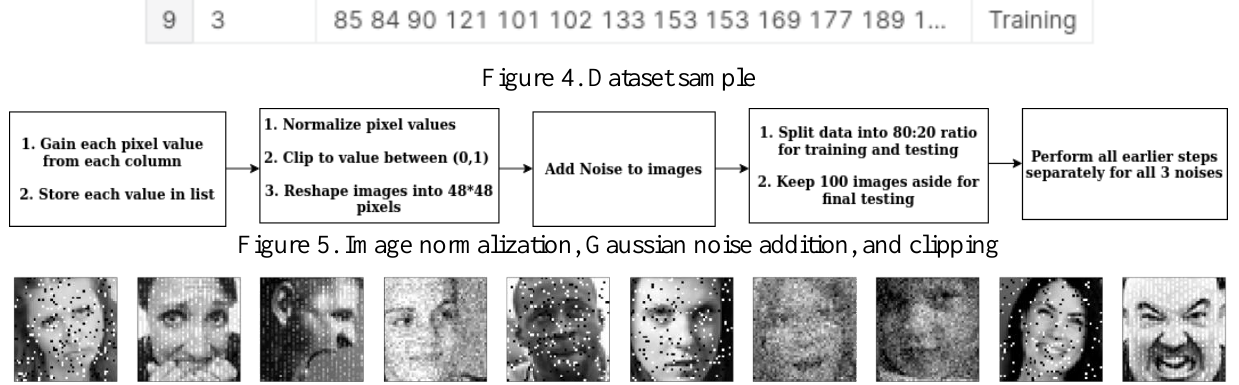
Figure 6. Dataset